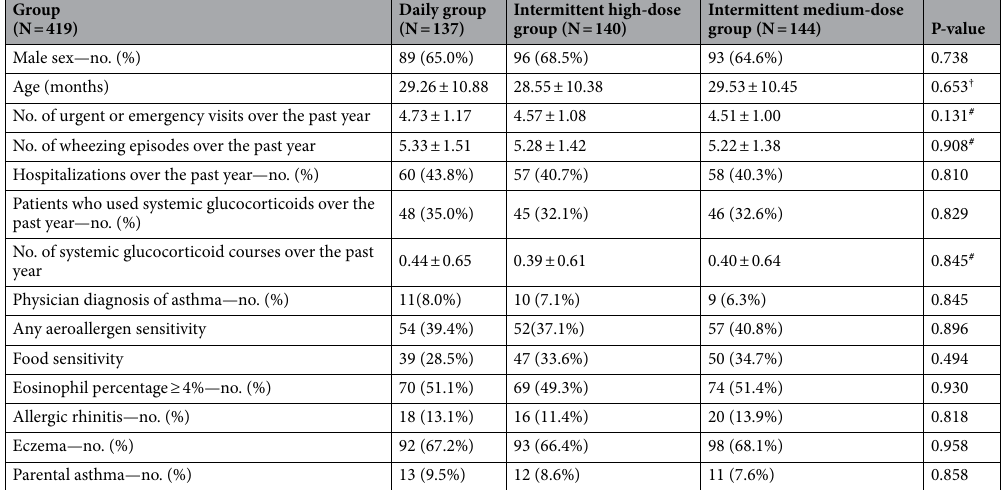
Table 1. Baseline characteristics of wheezing patients. Categorical variables are presented using proportions and were analysed using the chi-square test. Plus–minus values are means ± SD. † One-way ANOVA. # Kruskal– Wallis test.